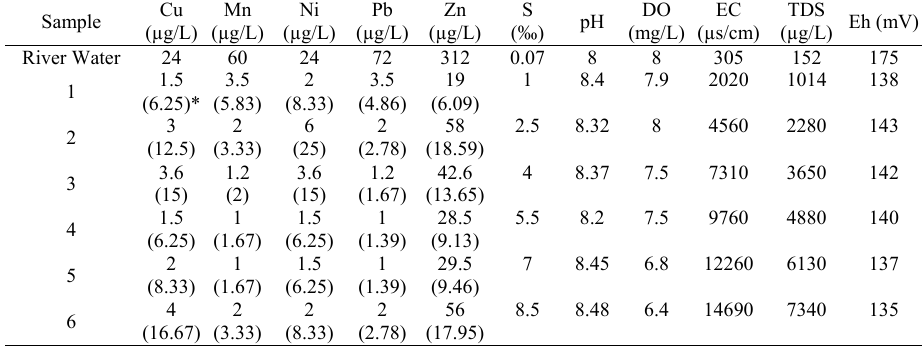
*Values within parenthesis show removal efficiency of heavy metals.